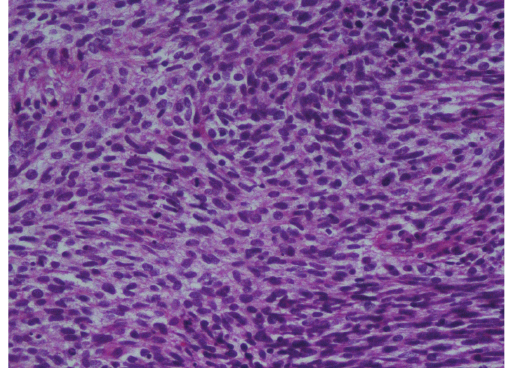
Figure 2: Medium power photomicrograph of the tumor showing moderately pleomorphic round to oval spindle-shaped nuclei with pale cytoplasm and hyperchromatic nuclei. Few scattered bizarre looking nuclei and many atypical mitosis are also noted (H & E, × 250).